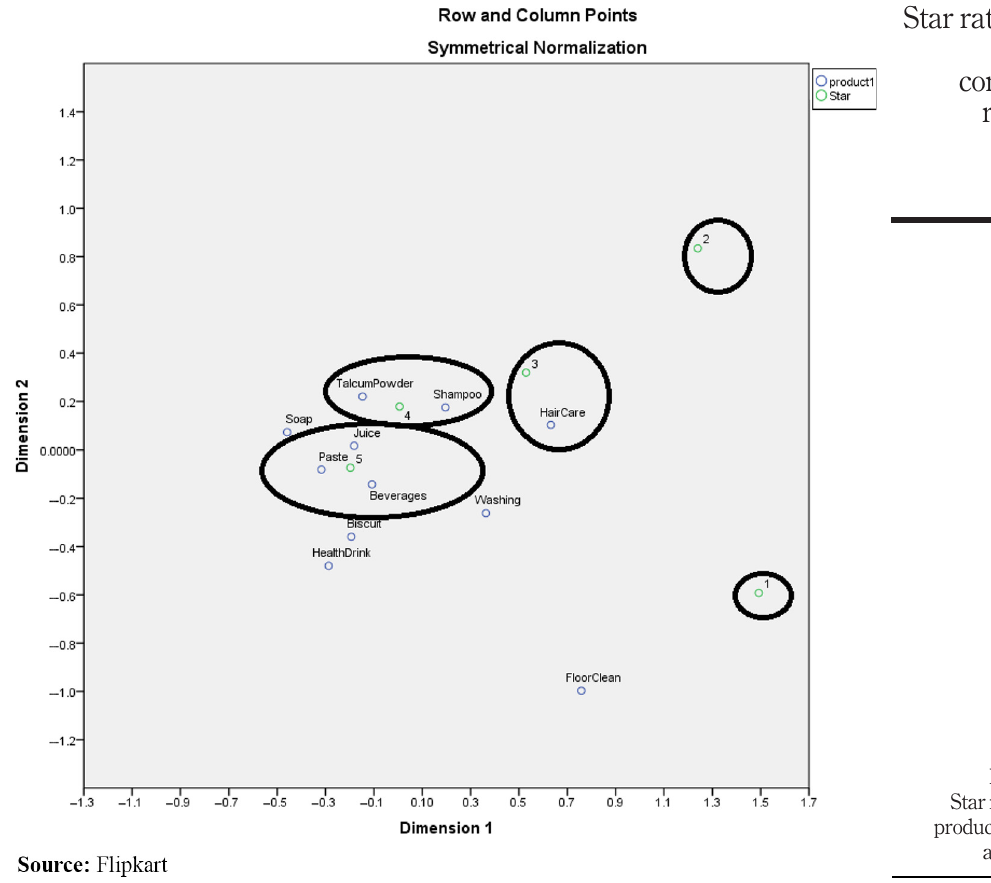
Figure 2. Star rating and product